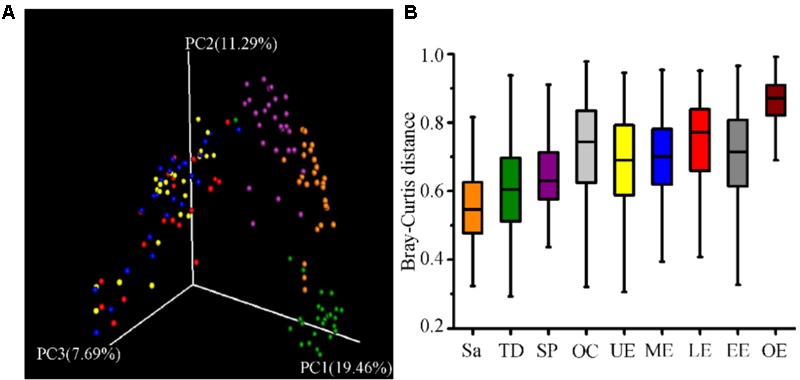
The similarity of community structure within and between the oral cavity and esophagus. (A) Three-dimensional ordination of human microbial profiles by principal coordinate analysis (PCoA) of average Bray-Curtis index in different body sites. Red indicating LE, Blue indicating ME, Brown indicating Sa, Green indicating SP, Purple indicating TD, and Yellow indicating UE. (B) The similarity of microbial diversity in three sites of the esophagus estimated by Bray-Curtis index. Values expressed as the median and quartitle of Bray-Curtis index. Sa, saliva; TD, tongue dorsum; SP, supragingival plaque; OC, oral cavity; UE, upper esophagus; ME, middle esophagus; LE, lower esophagus; EE, entire esophagus; OE, oral cavity and esophagus.